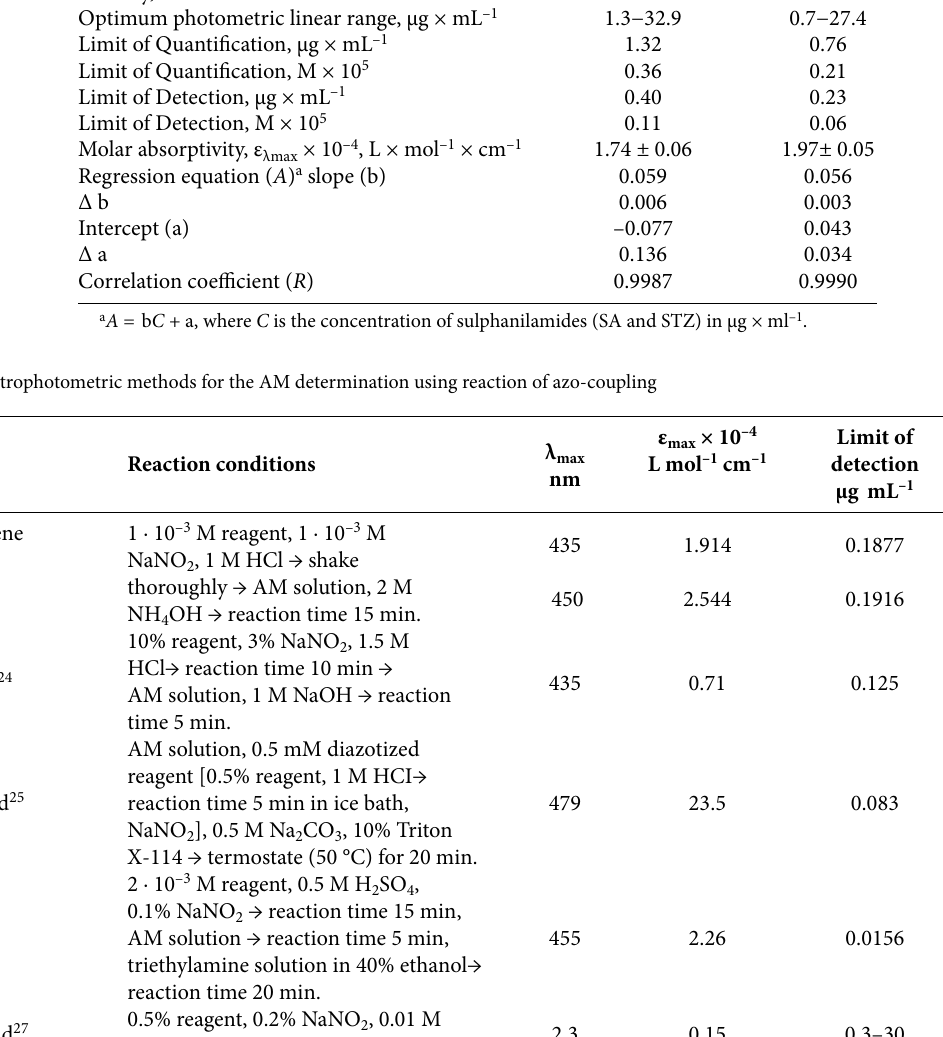
Table 3. Analytical characteristics of the formed azo compound and validation results of AM spectrophotometric determination with SA and STZ. С НСІ = 0.6 М, С SA = 4.5 ∙ 10 –4 М, C NaNO